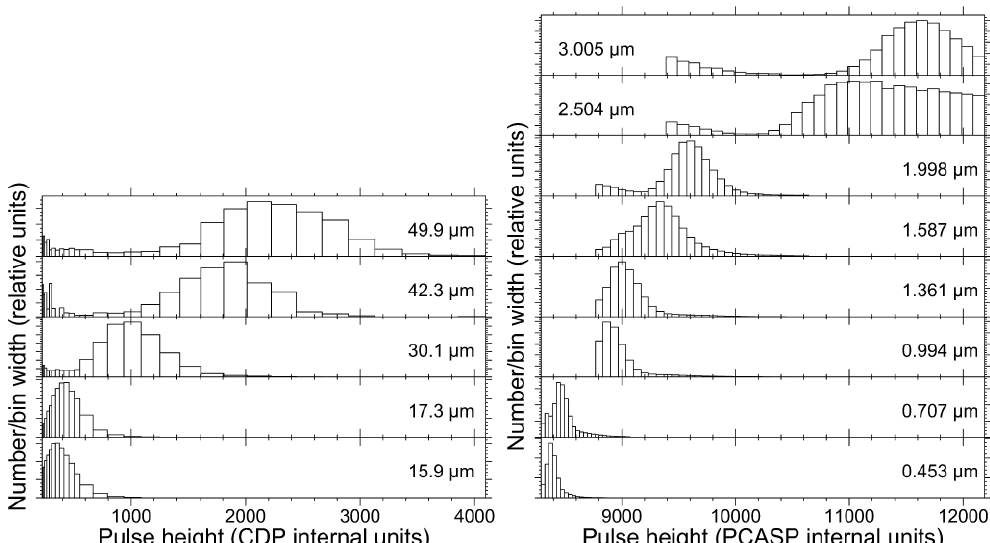
Fig. 3. Particle response distributions generated during calibration of the CDP (left) and PCASP (right). The horizontal axis shows the instrument response to the particles and the vertical axis shows the number of particles measured in each response bin. The labels indicate the mode diameter of the particles used to generate each distribution. For the PCASP only a subset of the used PSL sphere particle distributions are shown and the high resolution is achieved by reprogramming the instrument to zoom in on the area of interest. The broad distribution for the 2.504µm spheres may be caused by the close proximity to a spike in the Mie-Lorenze curve. The CDP particle distributions were generated using glass